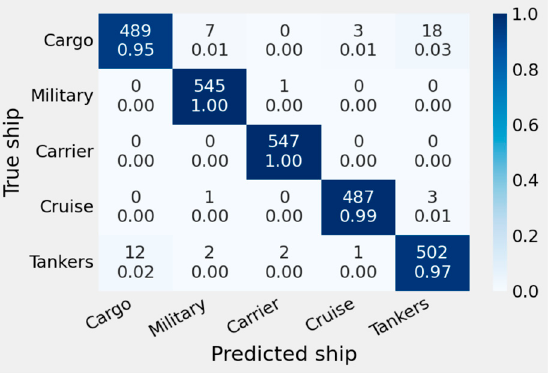
Figure 9. Confusion matrix for MARVEL dataset.